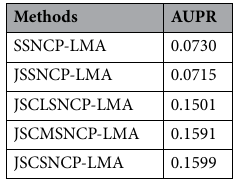
Table 2. Comparison of AUPR values for Influence of the change of model itself in fivefold